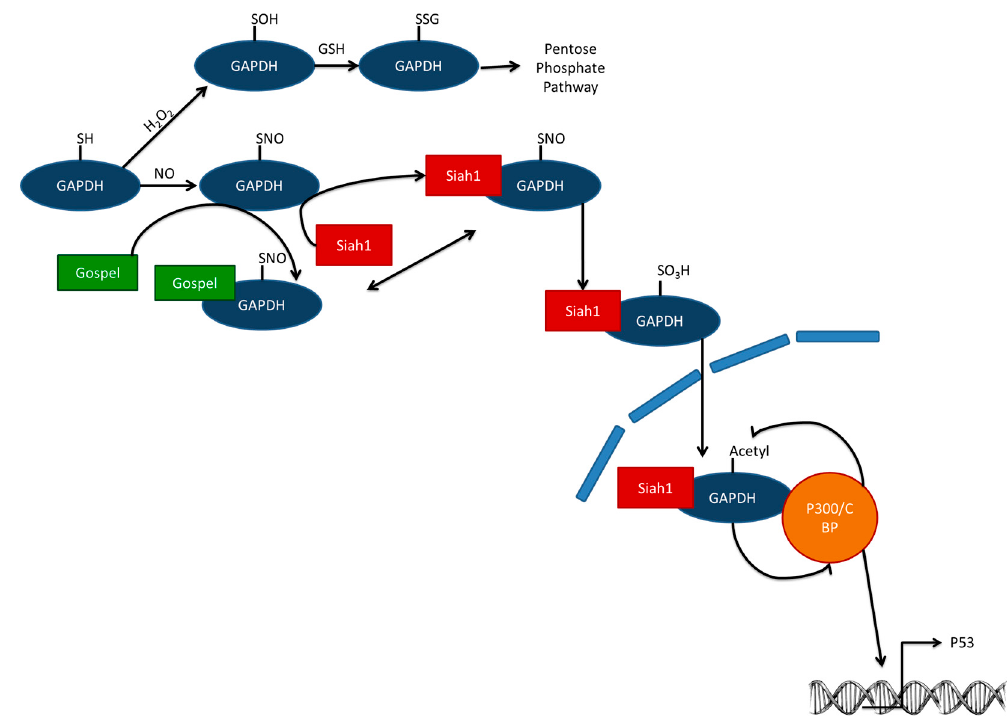
Figure 2. GAPDH can be oxidized and S -glutathionylated, which inhibits its glycolytic function and directs a metabolic switch towards the pentose phosphate pathway. If there is too much stress, not only is GOSPEL S -nitrosylated, but also GAPDH, which now prefers binding Siah1 instead of GOSPEL. Siah1 has a nuclear localization signal. In the nucleus, GAPDH complexes with the co-activator CREB-binding protein (CBP)/p300. CBP/p300 subsequently acetylates GAPDH. Acetylated GAPDH boosts the CBP/p300 acetylating function. This enhances transcription of GAPDH downstream target genes including cell death regulator p53. GAPDH = glyceraldehyde-3-phosphate dehydrogenase; GOSPEL = GAPDH's competitor of Siah Protein Enhances Life; Siah1 = Seven in absentia homolog; GSH = glutathione; H 2 O 2 = hydrogen peroxide.